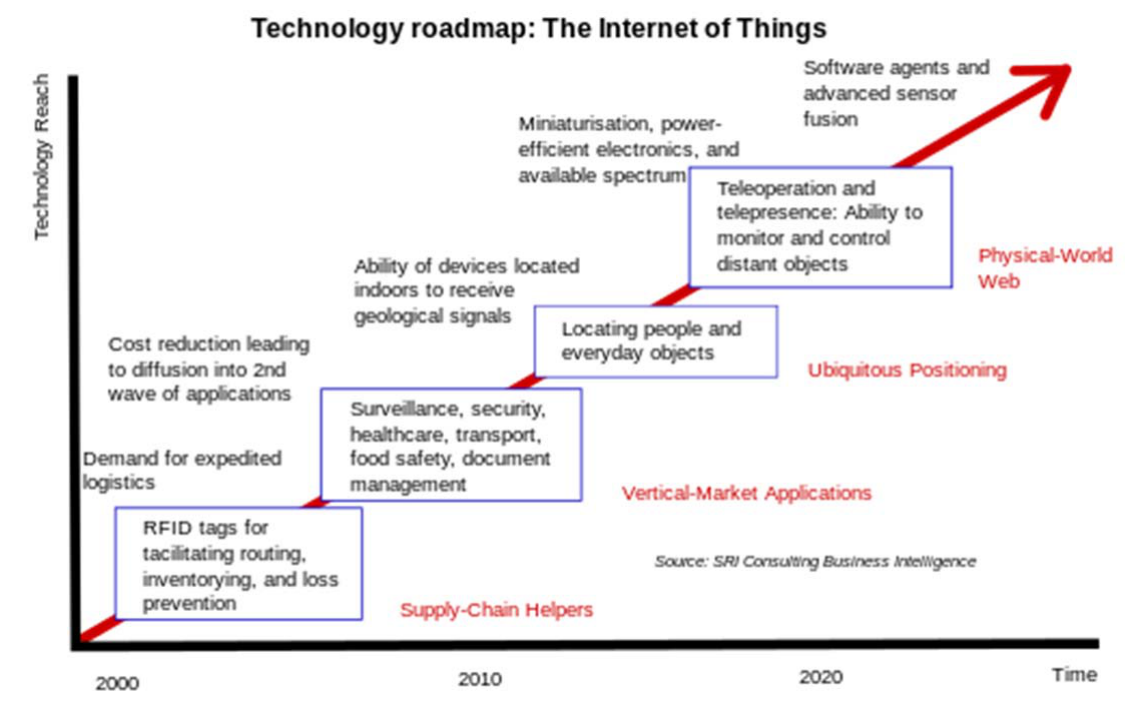
Figure 1. Development of IoT technologies in time